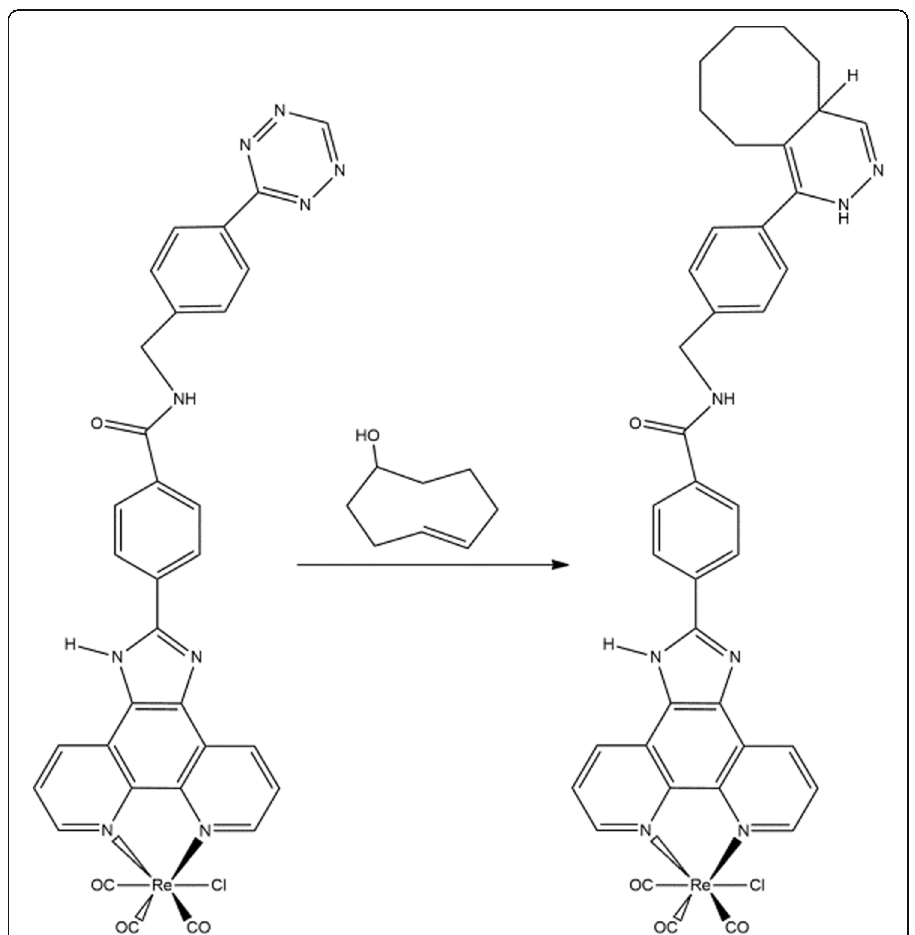
Fig. 2 Synthesis of click-based Re(I)-tricarbonyl